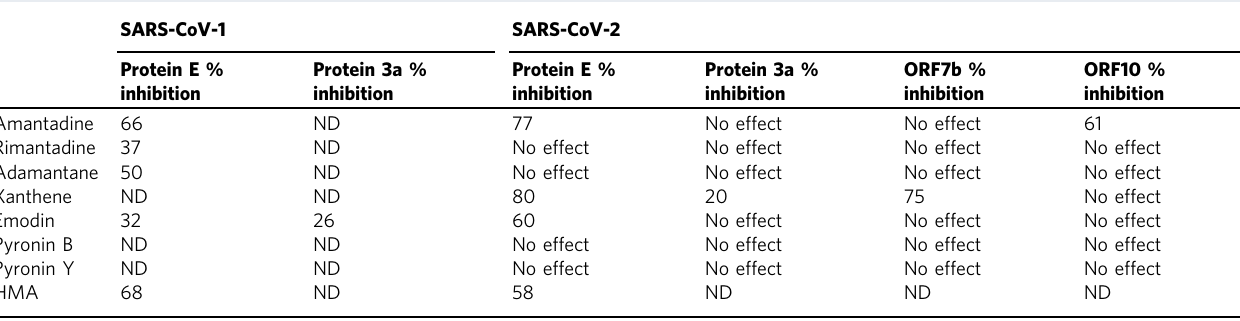
Table 1 The effects of selected drugs on protein E and protein 3a from SARS-CoV-1 and -2, and ORF7b and ORF10 from SARS-